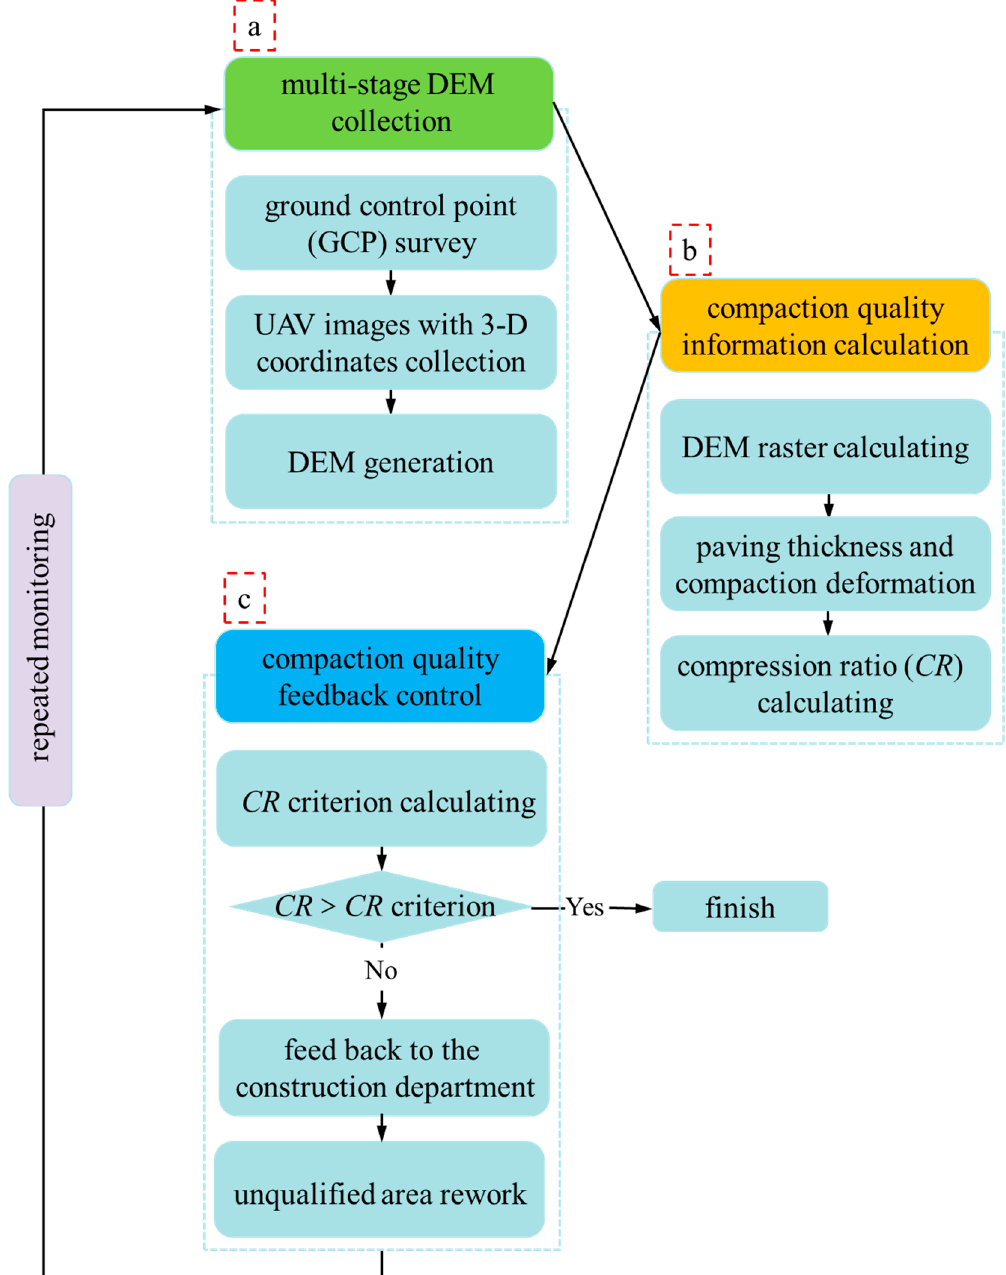
Figure 1. Compaction quality monitoring and control system processing